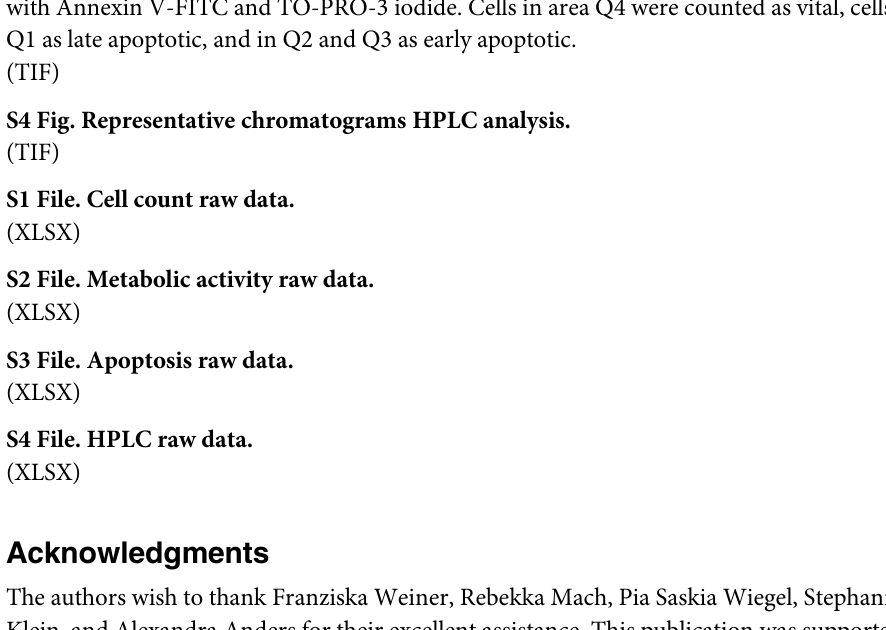
S1 Fig. Bliss values. Bliss values of the combination of DCA and metformin calculated for the effect on the metabolic activity of Adcarc1258 (A- and B), TCC1506 (C- and D), and fibro- blasts (C and- F) over 48 h (A, C, and E) and 96 h (B, D, and F). Bliss values after exposure to several doses of DCA (first top row), and metformin (first left hand column) in different com- binations of DCA and metformin (all columns and rows doses intersections) Positive Bliss val- ues are highlighted in green, Bliss values equal to zero are highlighted in yellow, negative Bliss values are highlighted in red. S2 Fig. Metabolic activity 48 h. Metabolic activity of fibroblasts, Adcarc1258, and TCC1506 after exposure to increasing metformin (A) or DCA (B) concentrations over 48 h. An untreated control of the respective cell line served as a 100% reference. Means and standard deviation are displayed; n = 6. Gray asterisks: significance difference between fibroblasts and Adcarc1258. Orange asterisks: significant difference between fibroblasts and TCC1506. Signifi- cance is set at p � < 0.05, p �� < 0.01, and p ��� < 0.001, respectively. S3 Fig. Representative dot plots of flow cytometry data. The three cell lines were stained with Annexin V-FITC and TO-PRO-3 iodide. Cells in area Q4 were counted as vital, cells in Q1 as late apoptotic, and in Q2 and Q3 as early apoptotic. S4 Fig. Representative chromatograms HPLC